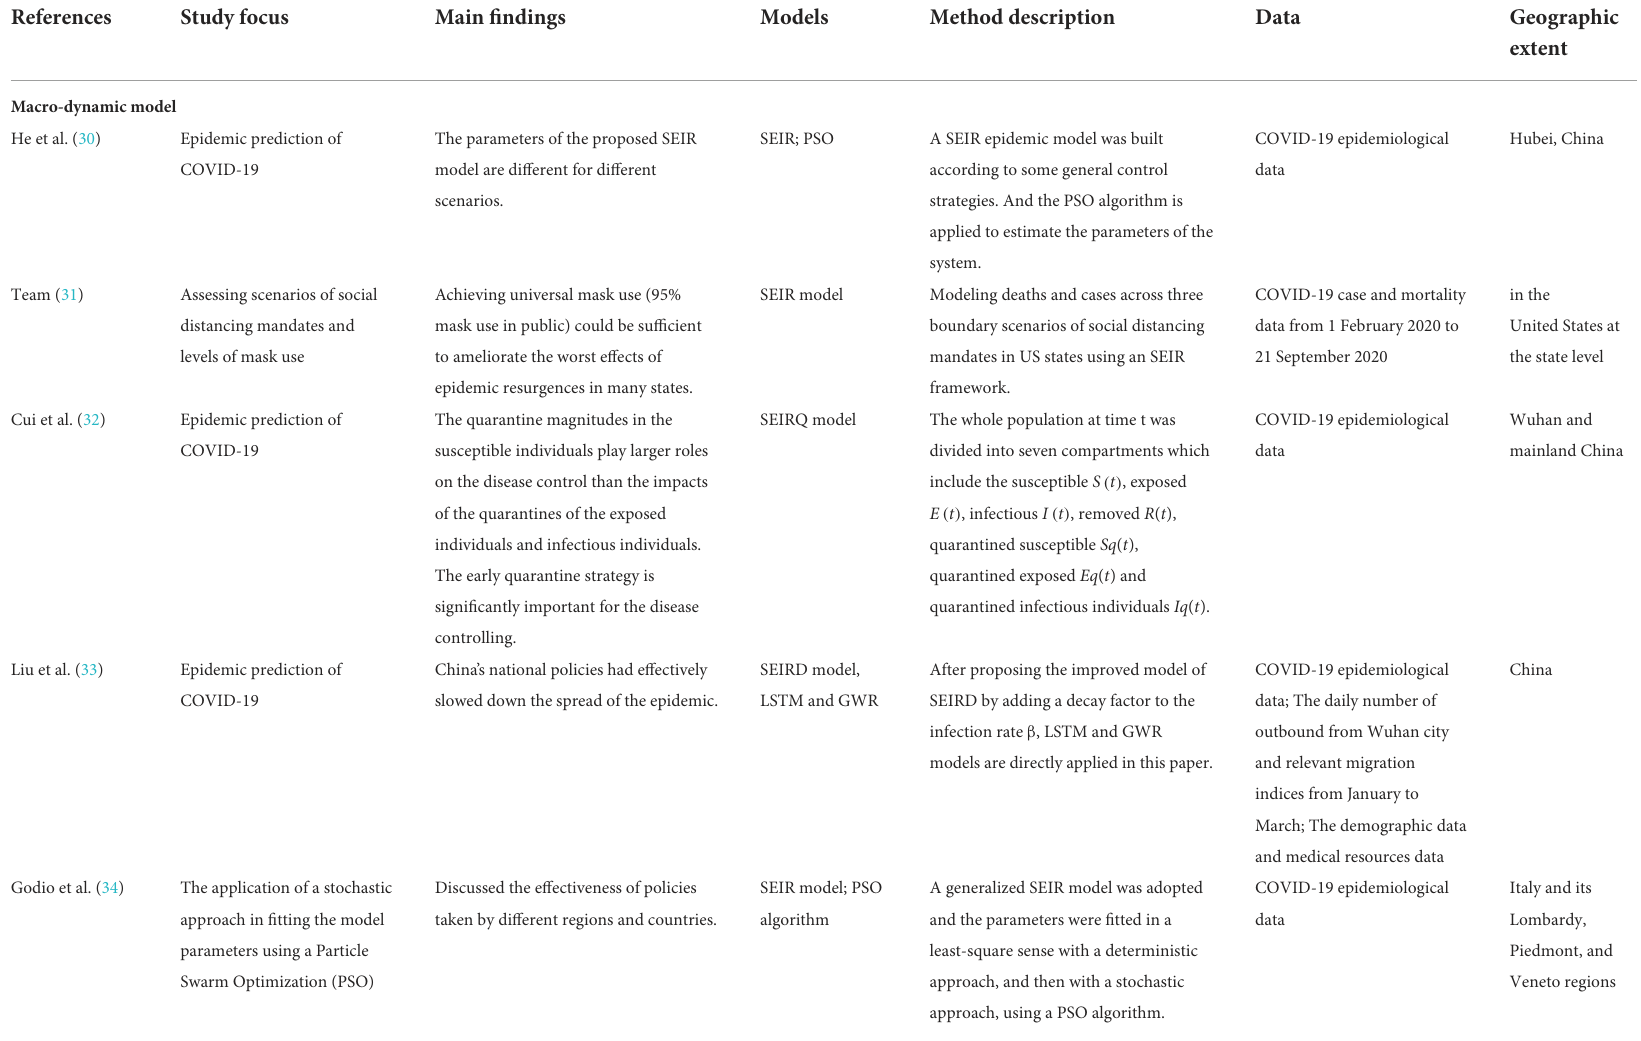
TABLE 1 References to macro- and micro-dynamic simulation models of COVID-19 are grouped according to research focus, main research findings, models, method description, data, and geographic